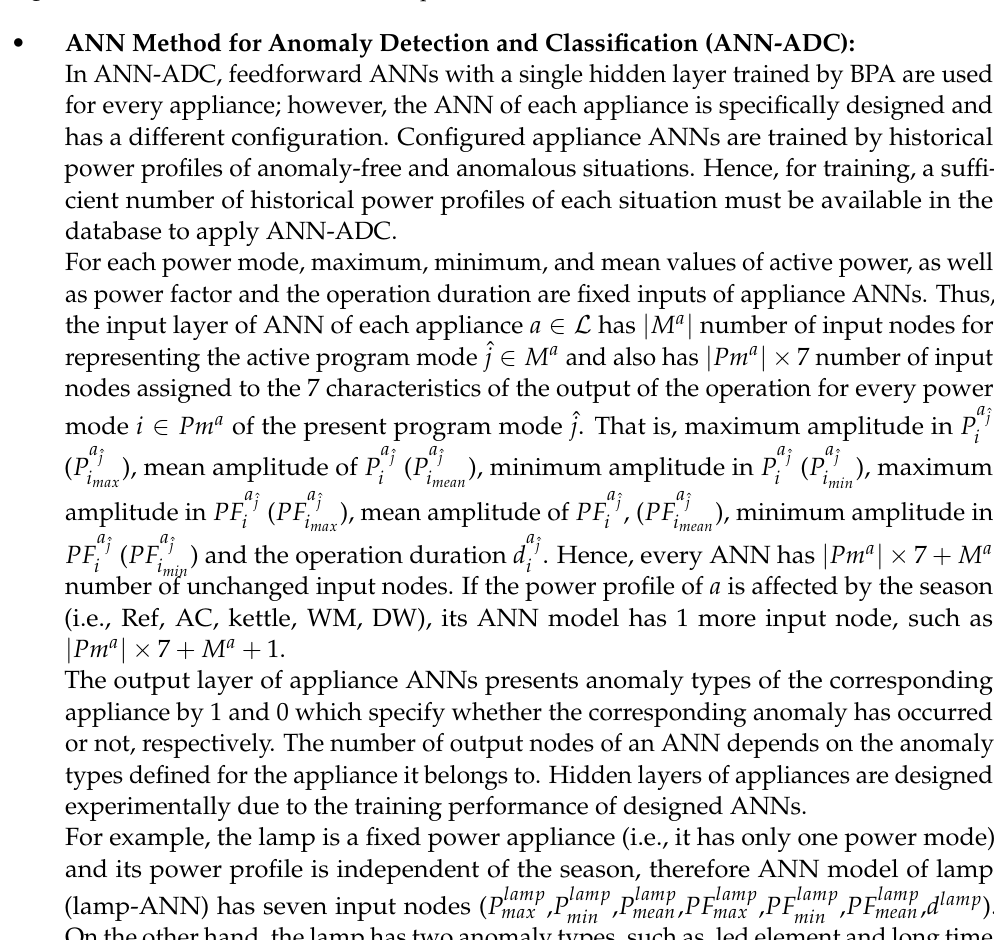
Figure 10. Control limits of a Ref for med power